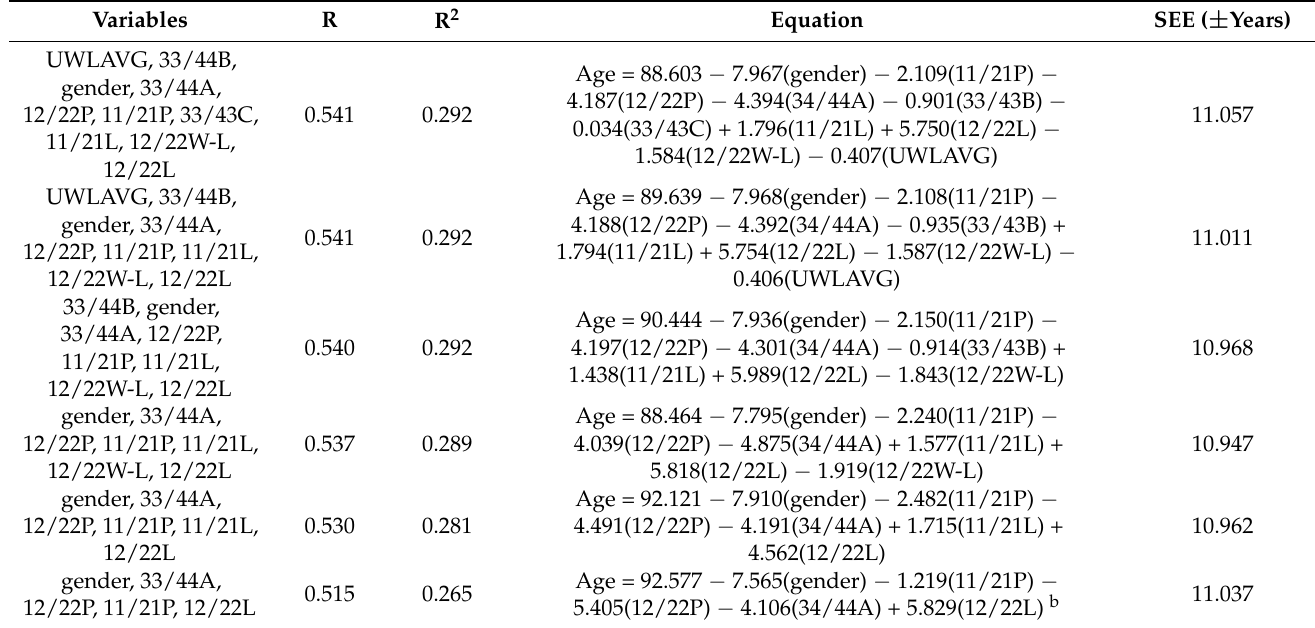
Table 6. Multiple backward regression models for the estimation of chronological age (in years) from the variables with the strongest correlation with age a